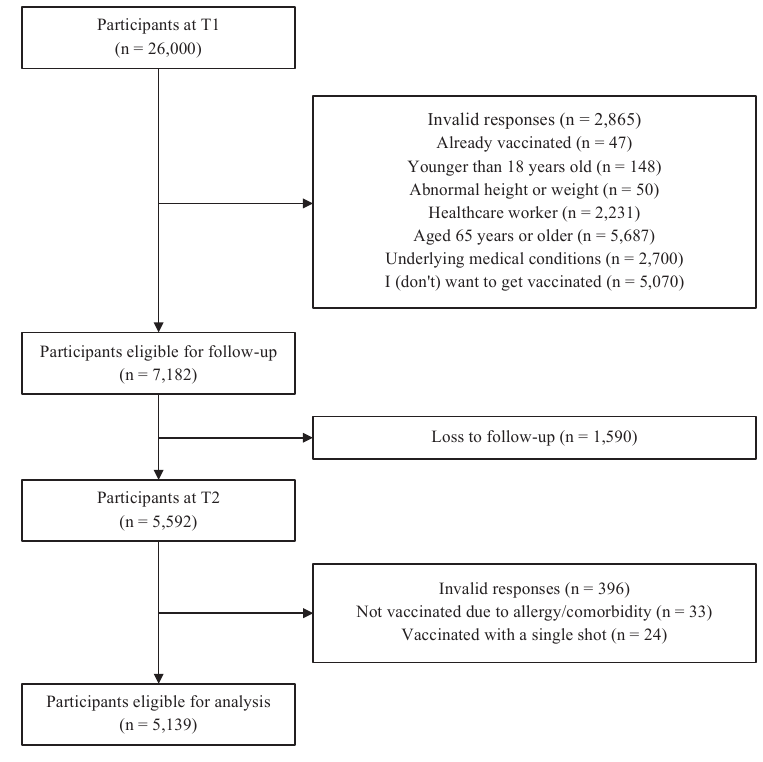
Fig. 1 Flowchart for eligible participants for